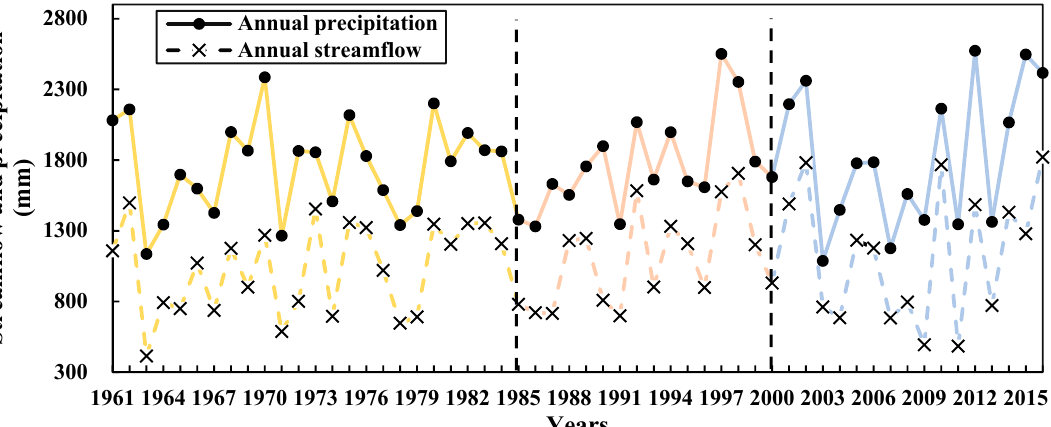
Figure A2. Annual precipitation and streamflow from 1961 to 2016 in the Jiujushui watershed (different colors represent three periods: reference, reforestation and fruit tree planting)